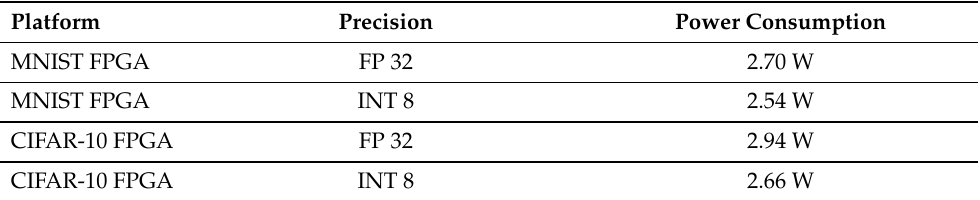
Table 6. Peak value of the power consumption of the FPGA reached during the run time, FP32—Full precision 32 bit, INT 8—8 bit integer.